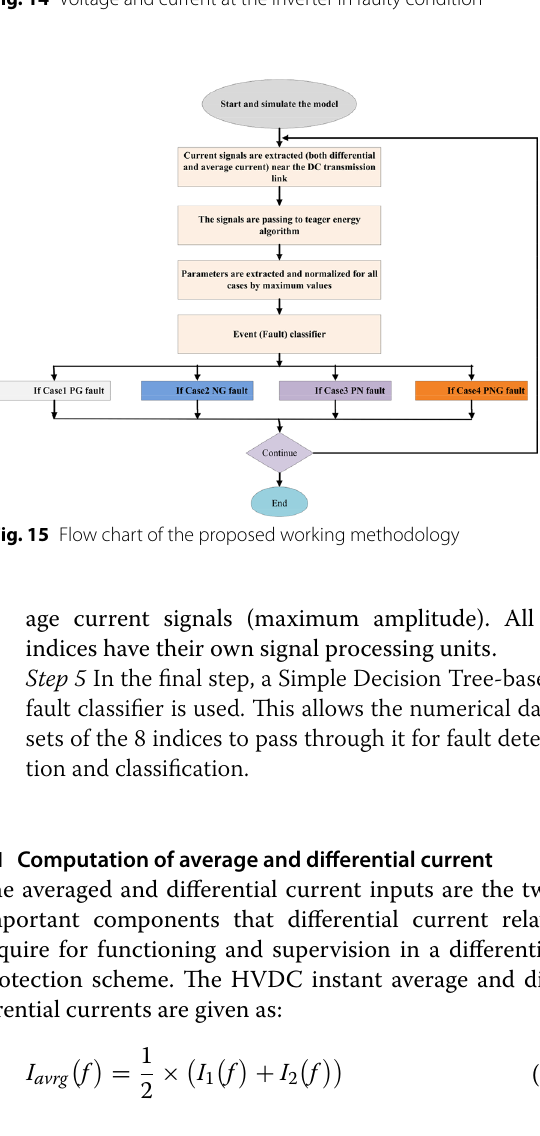
Fig. 14 Voltage and current at the inverter in faulty condition